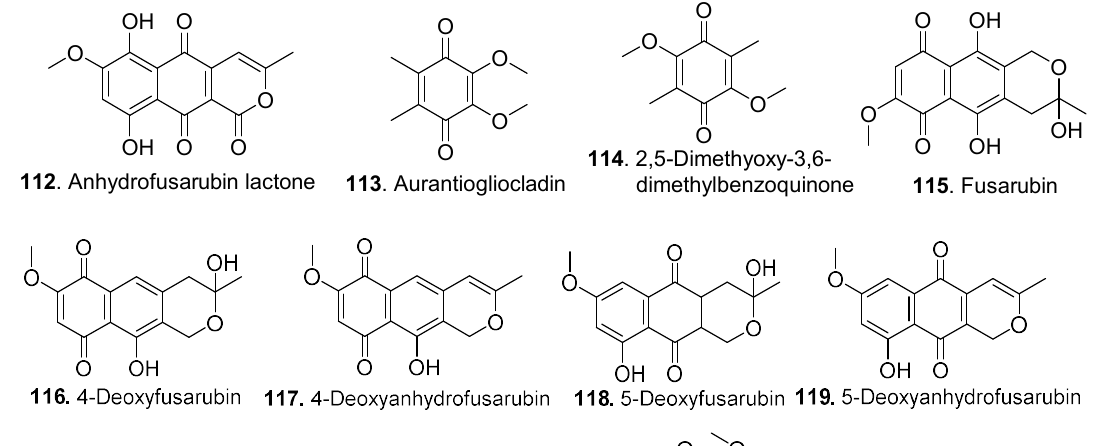
Figure 5. Pyranones isolated from Clonostachys fungi.